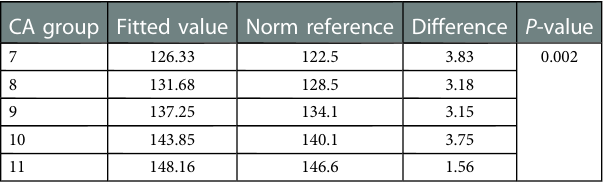
TABLE 3 Comparison between the P50th height (cm) of fi tted values and norm references.